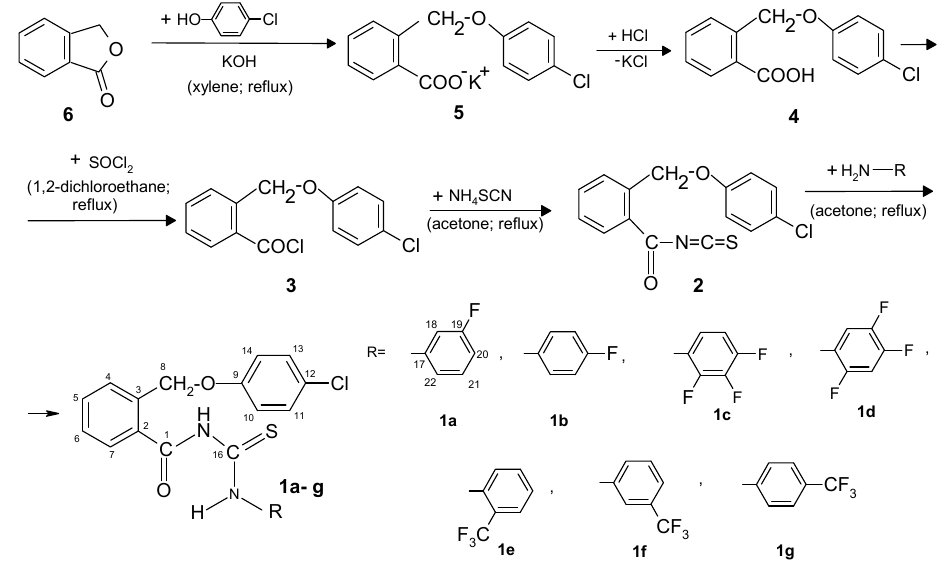
Figure 2. The synthetic route of the new benzamides 1a- g .